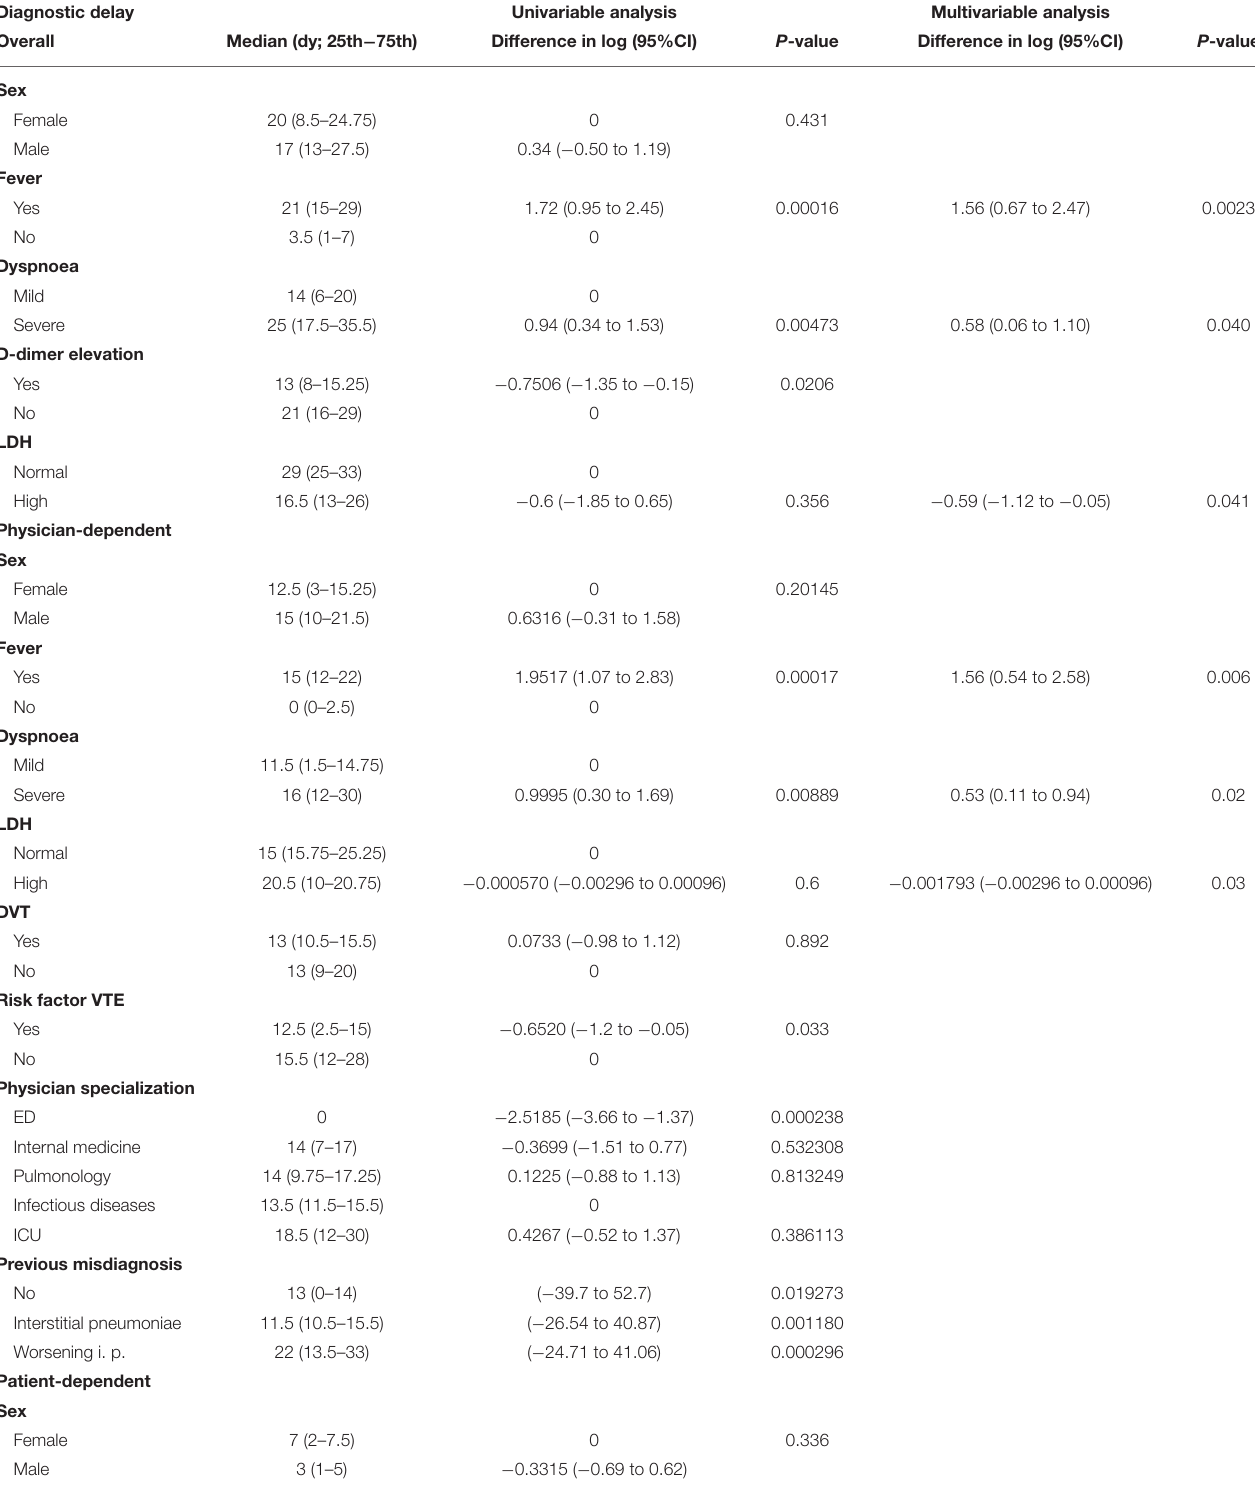
TABLE 4 | Univariable and multivariable analysis for the most relevant characteristics considered for overall, physician-dependent and patient-dependent diagnostic delay in COVID-19 patients affected by pulmonary embolism. Diagnostic